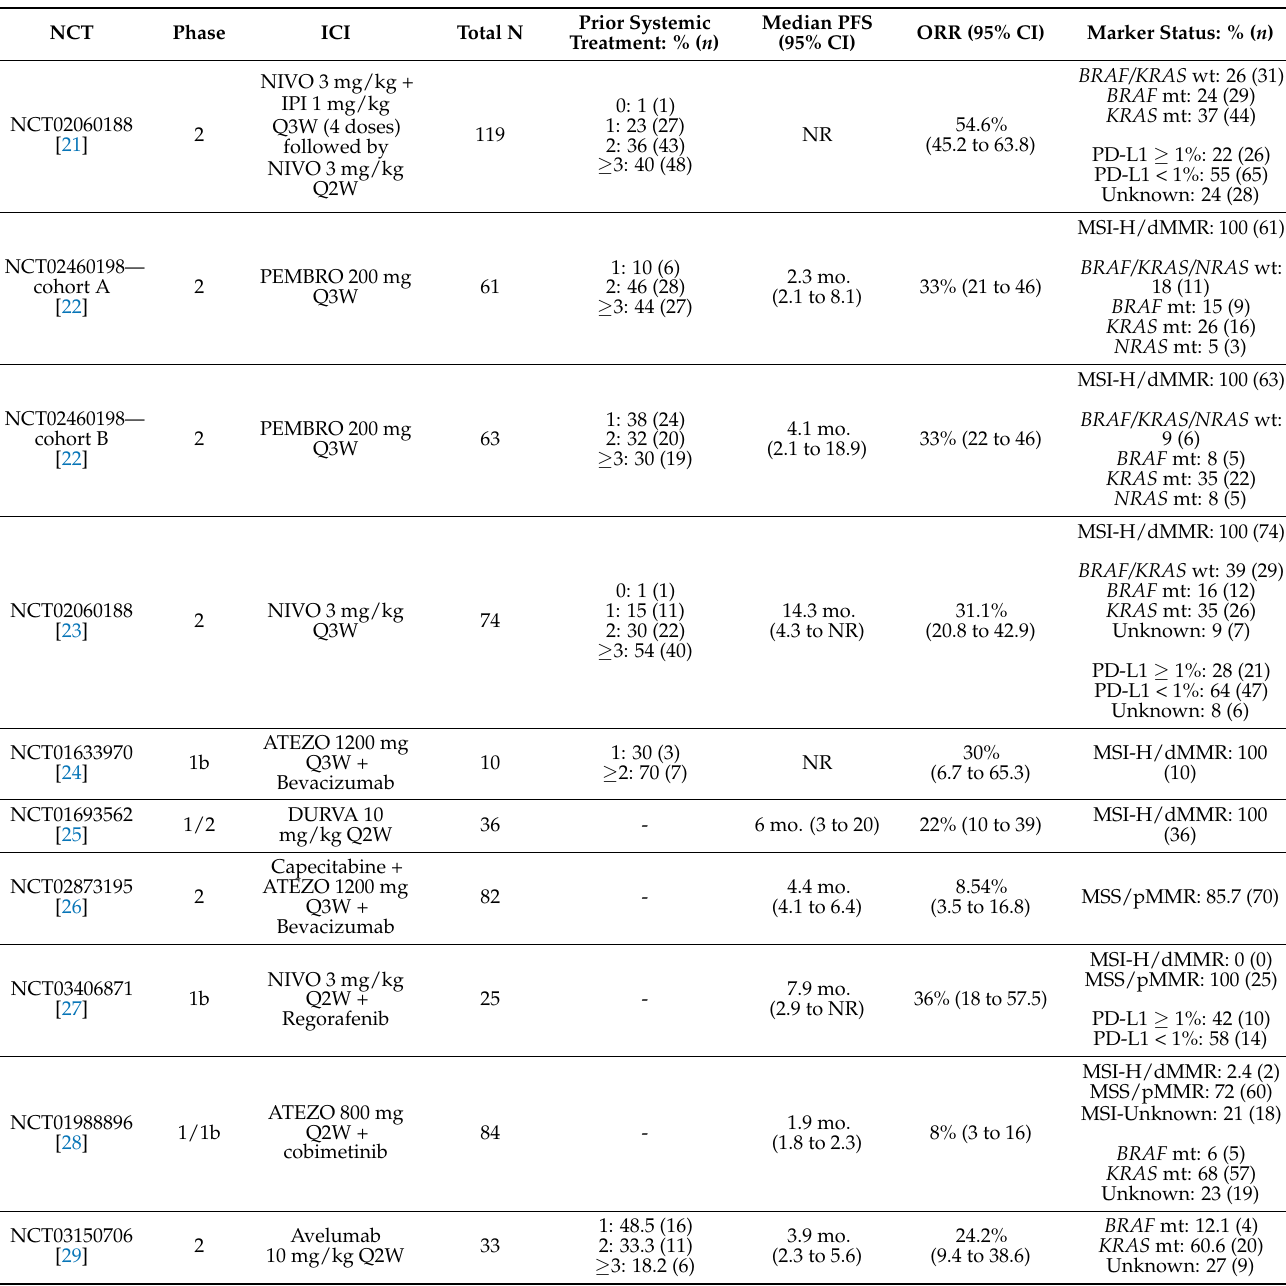
Table 1. List of studies included in this systematic review. ICI—immune-checkpoint inhibitor; NIVO—nivolumab; IPI—ipilimumab; PEMBRO—pembrolizumab; ATEZO—atezolizumab; DURVA—durvalumab; TREM—tremelimumab; Q3W—every 3 weeks; CI—confidence interval; PFS—progression-free survival; ORR—objective response rate; PD-L1— programmed cell death-1 ligand 1; mo—months; MSI-H—microsatellite instability-high; MSS—microsatellite